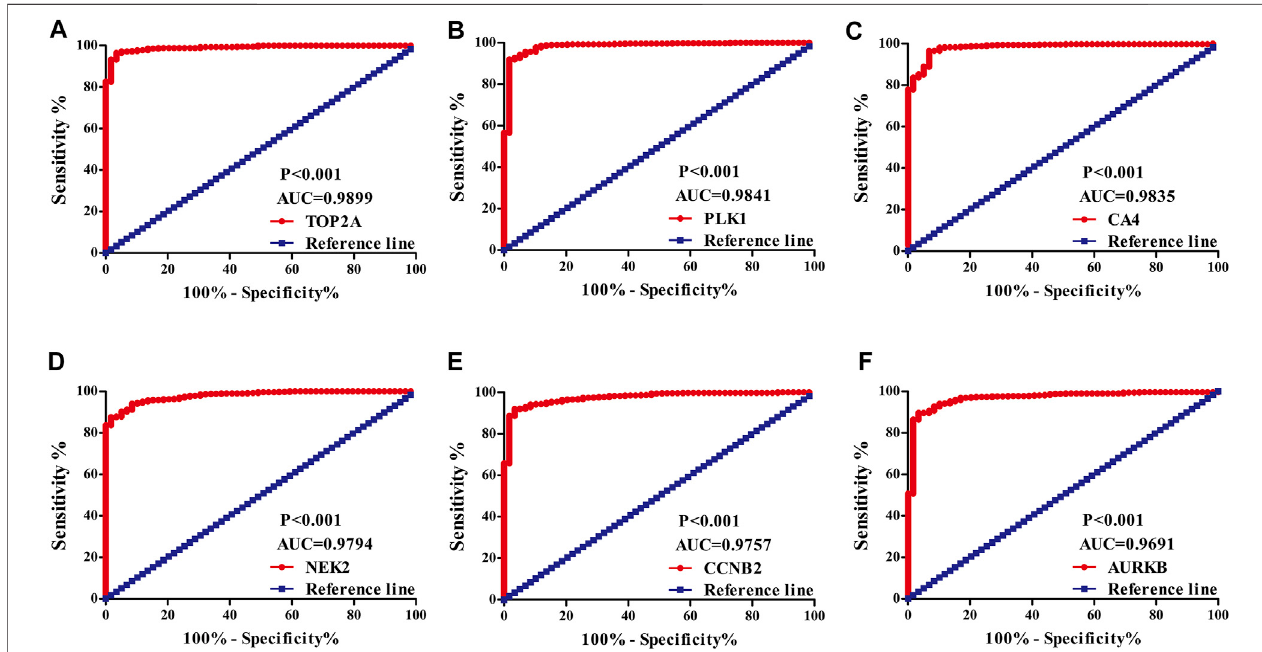
FIGURE 3 | The diagnostic value of quercetin-related differentially expressed target genes in LUAD via the ROC analysis. Note: ROC, Receiver operating characteristic; LUAD, lung adenocarcinoma.